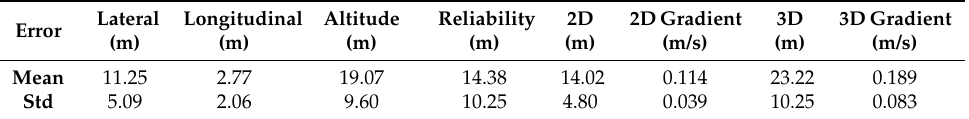
Figure 13. Experiment 4: positioning error and reliability estimation result. The top panel represents the positioning error in lateral, longitudinal and altitude directions, respectively. The bottom panel represents the estimated reliability and 3D positioning error of SLAM. Table 5. Experiment 4: Performance of NDT-based graph SLAM in dense urban area with dense traffic condition.